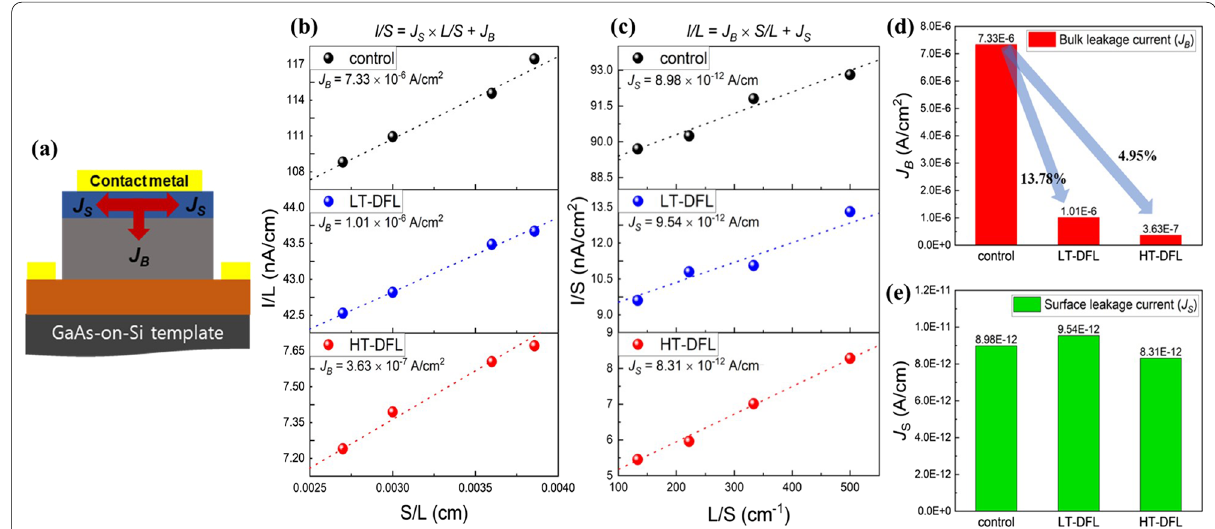
Fig. 5 a Schematic of two possible dark current paths in a p – i – n GaAs diode on Si. b S/L–I/L relationship of GaAs p – i – n diode on Si at 1 V with various pattern sizes. c L/S–I/S relationship of GaAs p – i – n diode at 1 V with various pattern sizes. d , e Extracted values of J B and J S of the HT‑DFL, LT‑DFL and control sample,